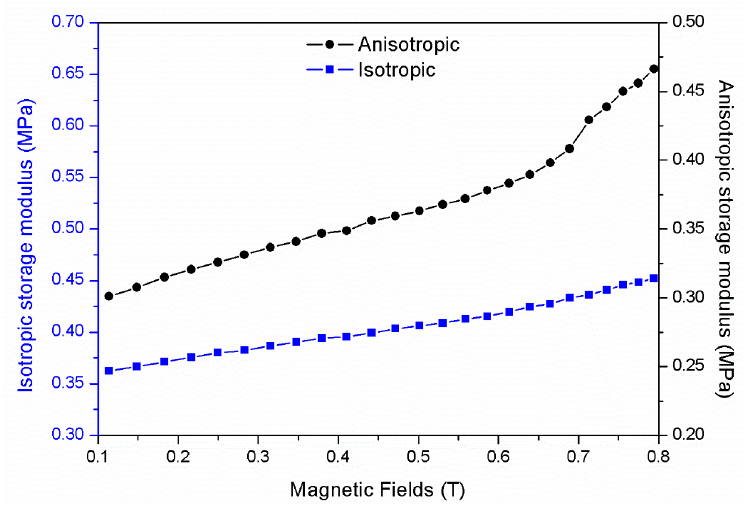
Figure 7. The MR effect of anisotropic and isotropic MRE at magnetic field of 0–0.8 T. Figure 7. The MR e ff ect of anisotropic and isotropic MRE at magnetic field of 0–0.8 Table 5. The MR effect on the storage modulus of the MRE.